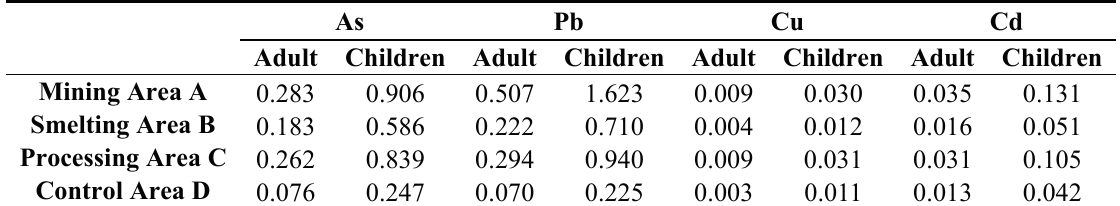
Table 10. Hazard quotients and risks for each heavy metal in soils.